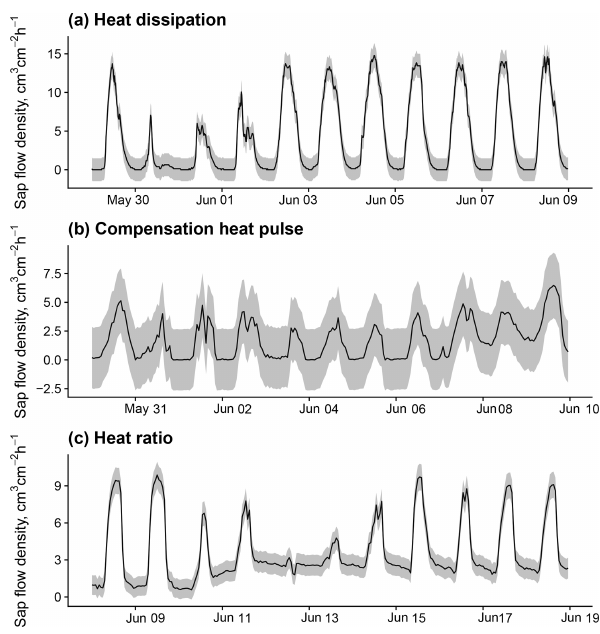
Figure B2. Sub-daily time series of sap flow and methodological uncertainty estimations (1 standard error) according to the model in Fig. B1 for 10d periods in trees measured with (a) heat dissipation, (b) compensation heat pulse, and (c) heat ratio sensors. Data for panel (a) from a Pinus sylvestris tree in dataset ESP_VAL_SOR; data for panel (b) from a Pinus sylvestris tree in GBR_DEV_CON; and data for panel (c) from a Eucalyptus victrix tree in